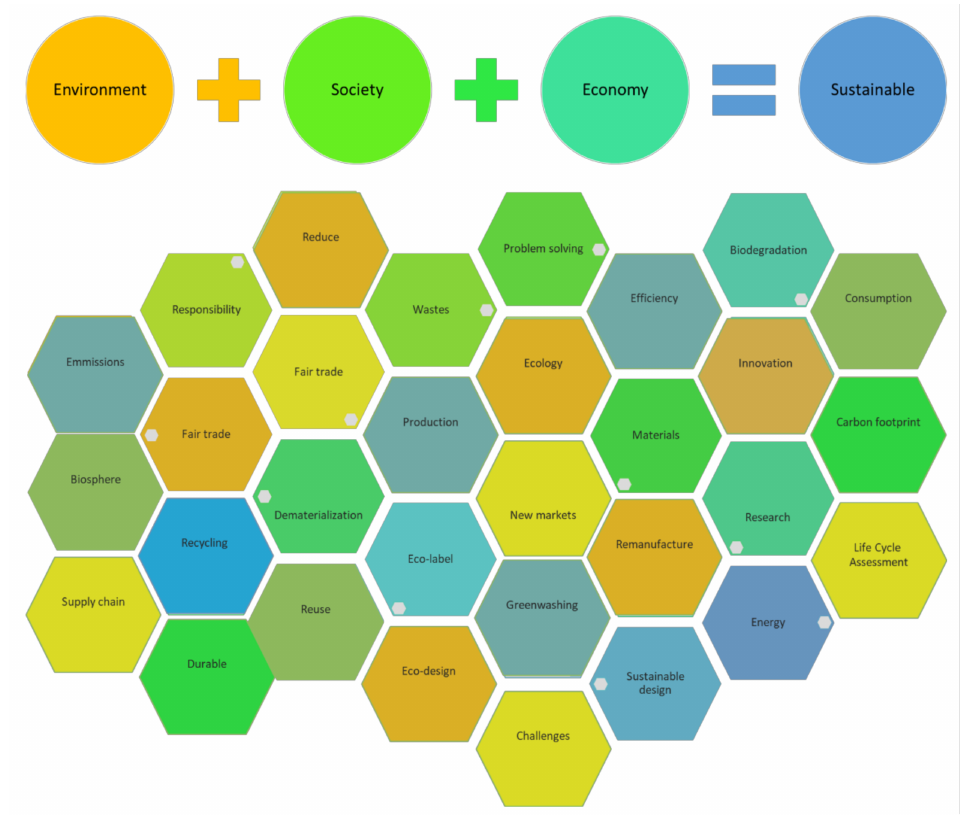
Figure 4. Sustainability and some associated